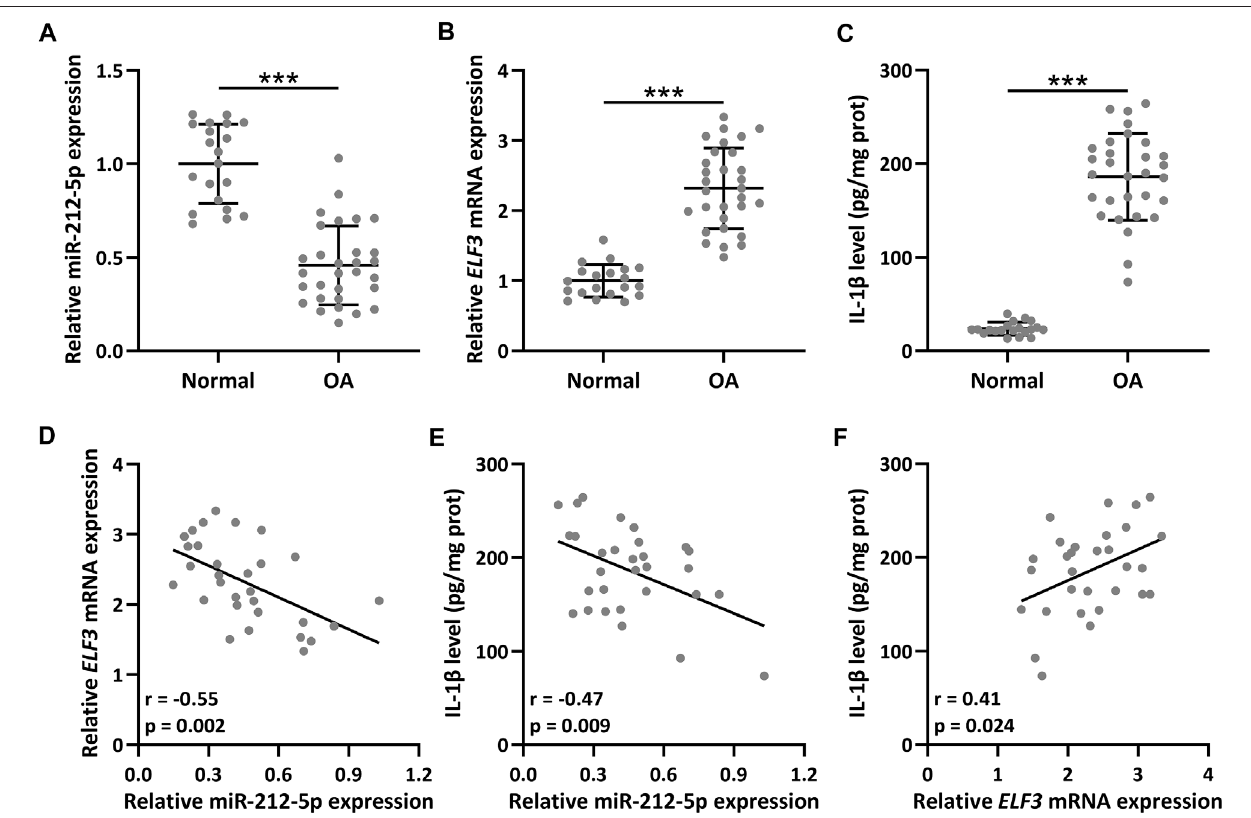
FIGURE1| TheexpressionofELF3andmiR-212-5p inOA( n =30)andnormalsynovialtissues( n =20).qRT-PCRwasutilizedtodetecttherelativeexpressionsof miR-212-5p (A) andELF3 (B) .ELISAwasusedtomeasuretheIL-1 β level (C) .Pearsoncorrelationcoef fi cientofmiR-212-5pandELF3mRNA (D) ,miR-212-5pandIL-1 β level (E) , ELF3 mRNA and IL-1 β level (F) in OA synovial tissues. n = 30. Mean ± SD. *** p <